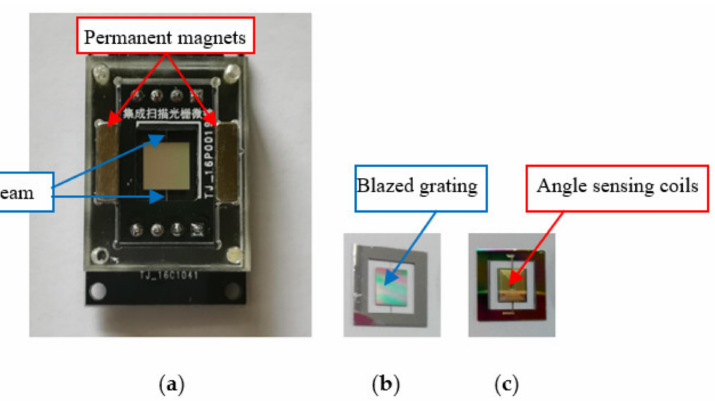
Figure 2. The MOEMS scanning grating mirror fixed on the PCB. ( a ) Fabricated scanning grating mirror. ( b ) Upper-side view. ( c ) Lower-side